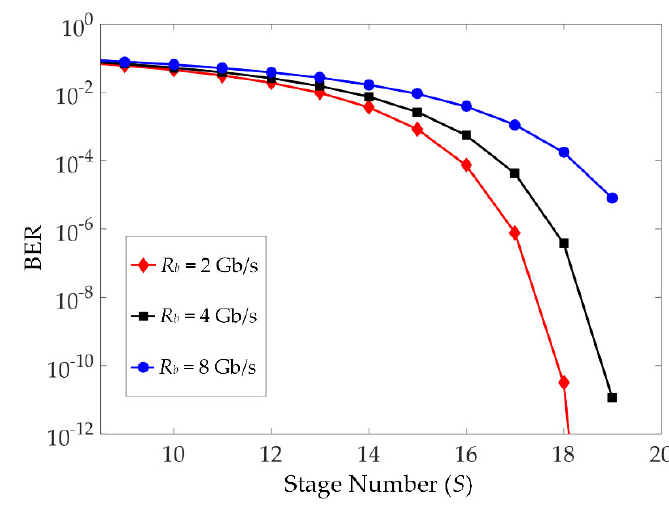
Figure 9. Bit-error rate (BER) versus the stage number of RIC.